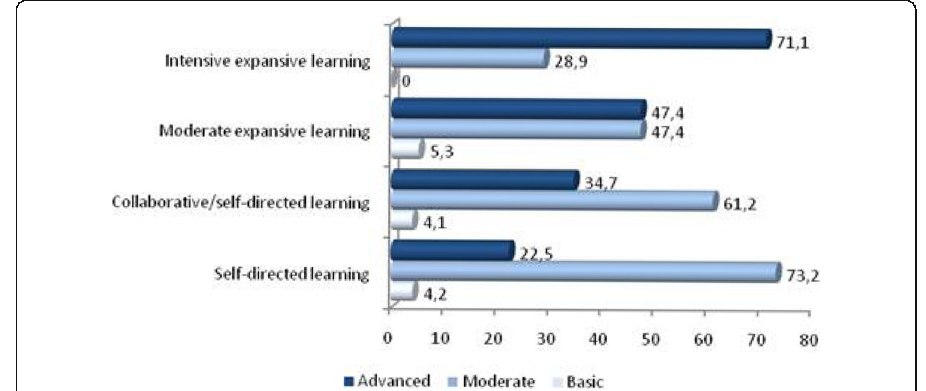
Fig. 7 Learning strategies and degree of digital